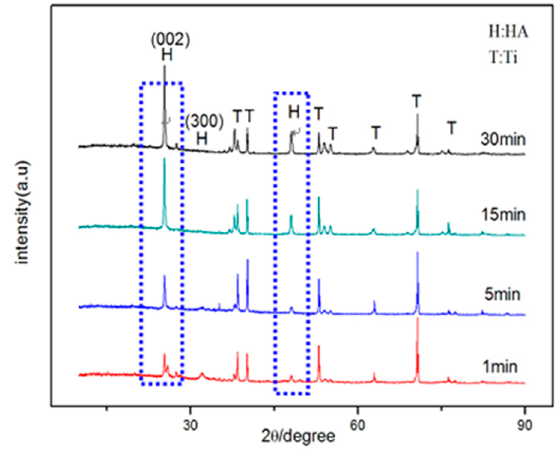
Figure 6. XRD spectra of HA coatings at various electrochemical deposition times from 1 min to 30 min.